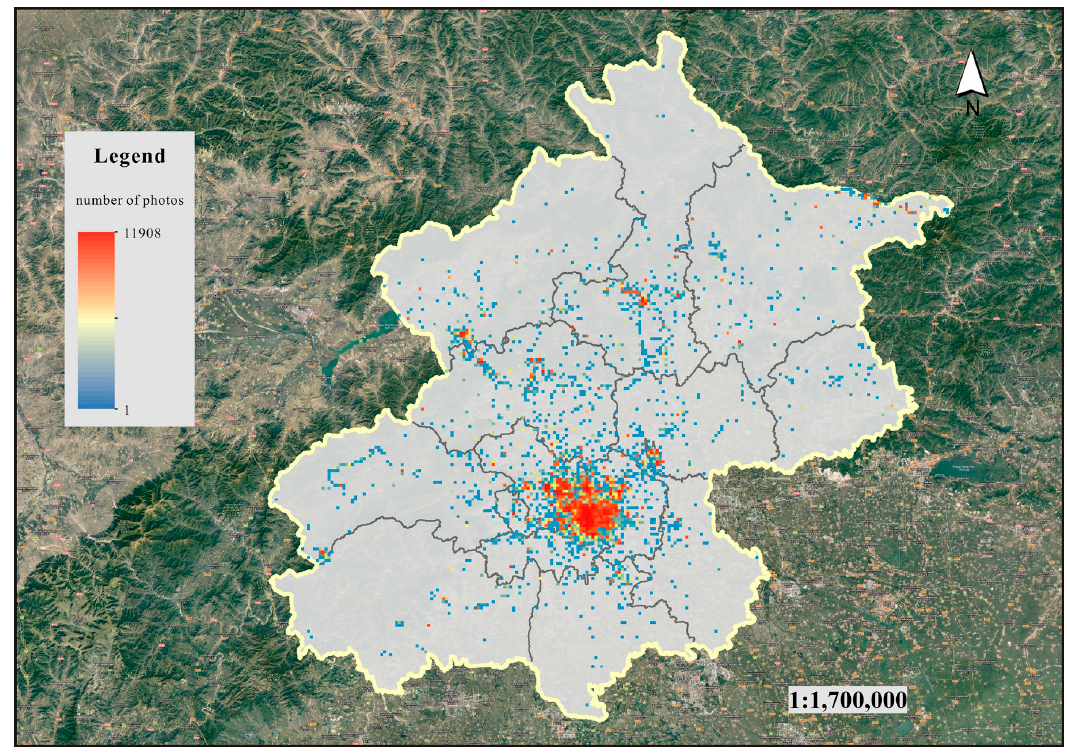
Figure 5. Geotagged photo distribution in the study area: Beijing.